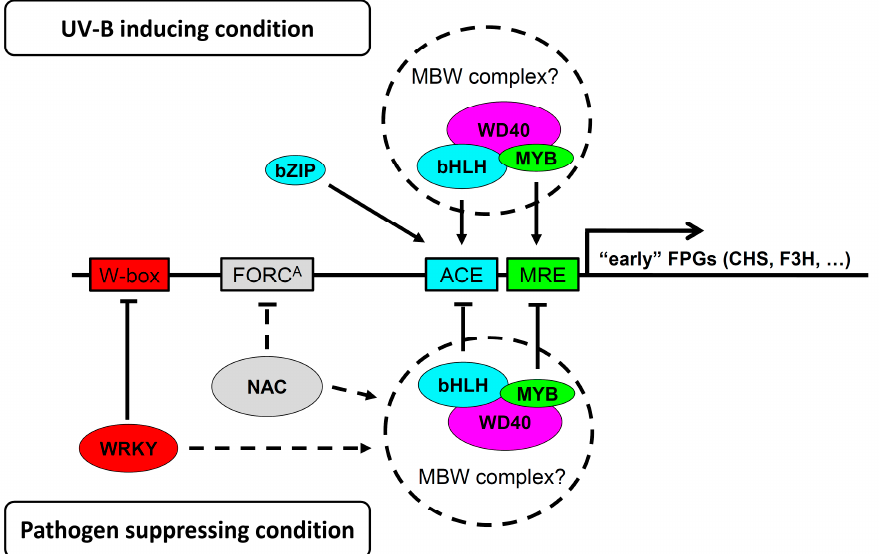
Figure 3. Graphical summary of potentially new processes involved in crosstalk between pathogen and UV-B induced signaling as discussed in the text. Identification of several conversely regulated MYB, bHLH, and WD40 TFs (Table 1) suggests that MBW complexes consisting of these TFs might also be regulating the “early” FPGs. Positive influence on FPG expression is deduced from genes that are co-regulated together with the CHS marker gene (being UV-B up- and flg22 down-regulated), while the negative impact is assumed from genes that are co-regulated with the FRK1 marker gene (being UV-B down- and flg22 up-regulated).